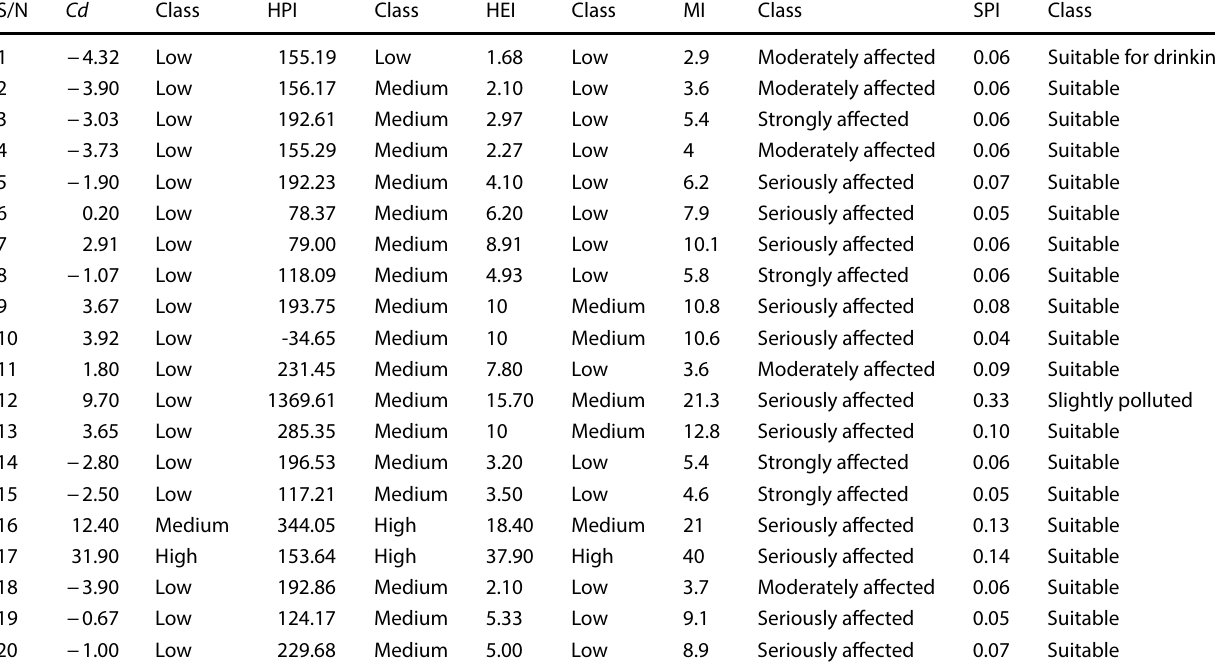
Table 3 Computed heavy metal pollution indices of the study